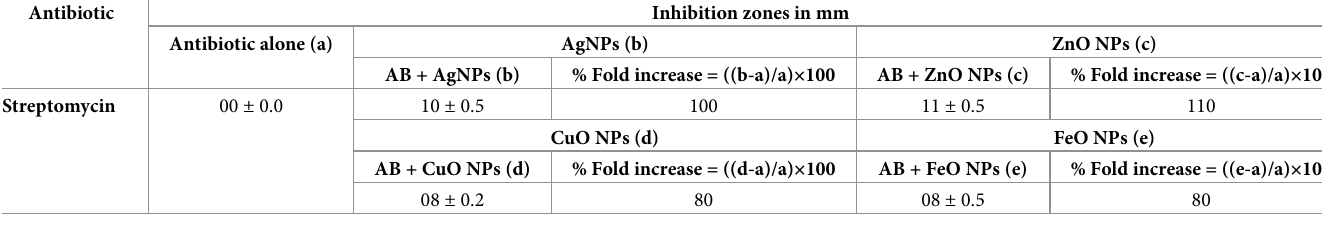
Table 2. Antibacterial activity of Streptomycin before and after conjugation with green synthesized NPs against S . aureus . Antibiotic Inhibition zones in mm Antibiotic alone (a) AgNPs (b) ZnO NPs (c) AB + AgNPs (b) % Fold increase = ((b-a)/a) × 100 AB + ZnO NPs (c) % Fold increase = ((c-a)/a) × 100 Streptomycin 00 ± 0.0 10 ± 0.5 100 11 ± 0.5 110 CuO NPs (d) FeO NPs (e) 08 ± 0.2 80 08 ± 0.5 80 Concentration expressed in μ